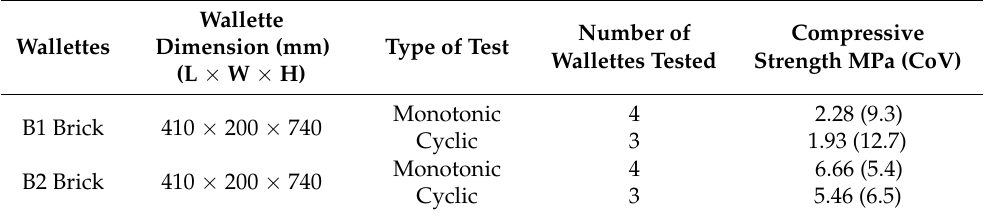
Table 1. Dimensions and observed compressive strength of test specimens (Adapted from